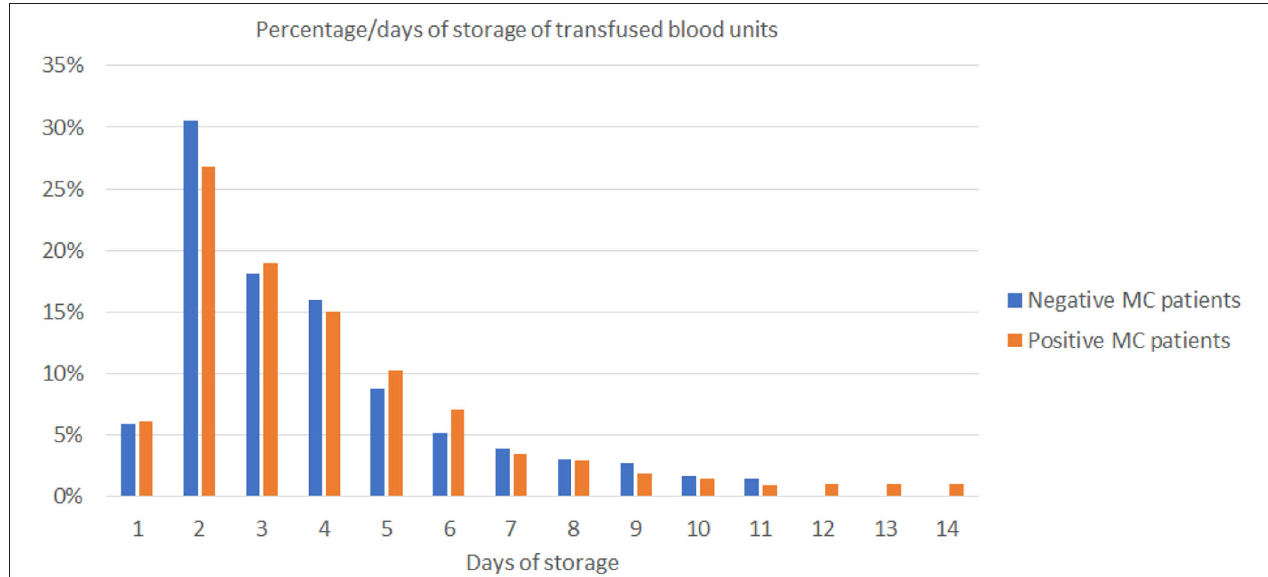
FIGURE 4 | The diagram shows the range of storage days of the 1,241 blood units that had been transfused on 11 non-MC (blue bars) and 1,173 blood units on 14 MC patients (orange bars). MC,